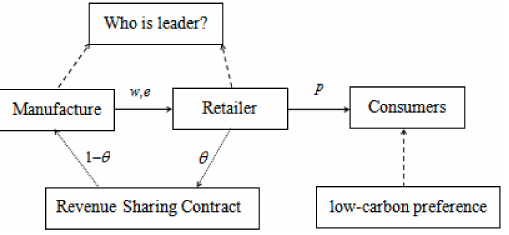
Figure 1. Production optimization in a low-carbon supply chain